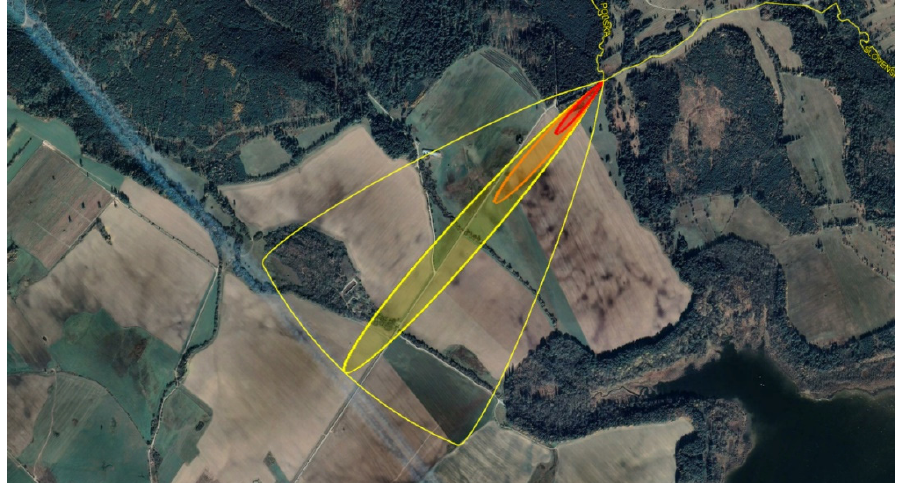
Figure 11. Graphical representation of the dispersion of a dangerous substance at the border crossing Bobrov-Wincerówka [24,25].